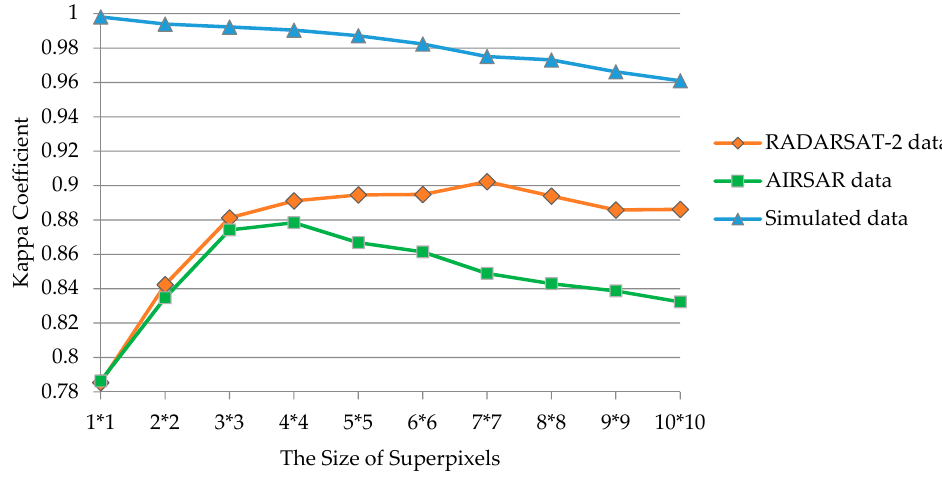
Figure 12. Kappa coefficients obtained by applying SP-KSEM-PLR to the simulated, RADARSAT-2 and AIRSAR images using different sizes of superpixels.